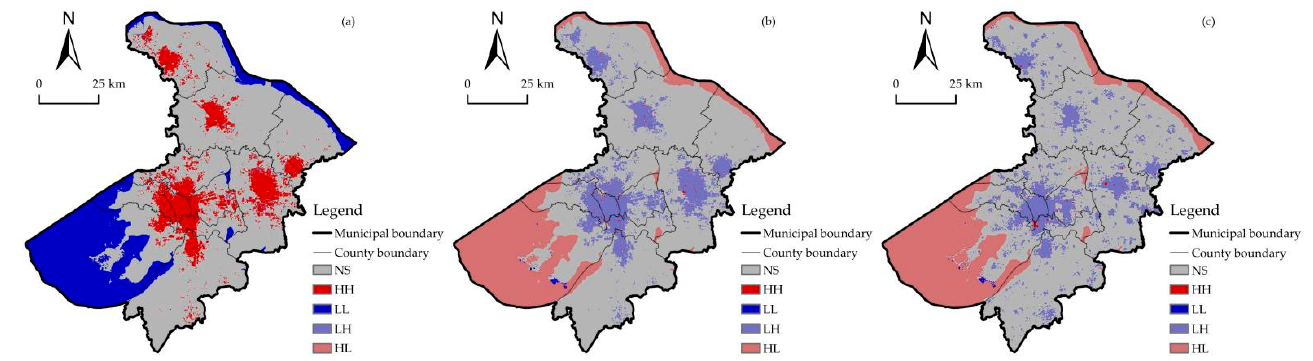
Figure 7. Comprehensive function relationship of production–living–ecological space: ( a ) Living– production spatial function; ( b ) Production–ecological spatial function; ( c ) Living–ecological spatial function.